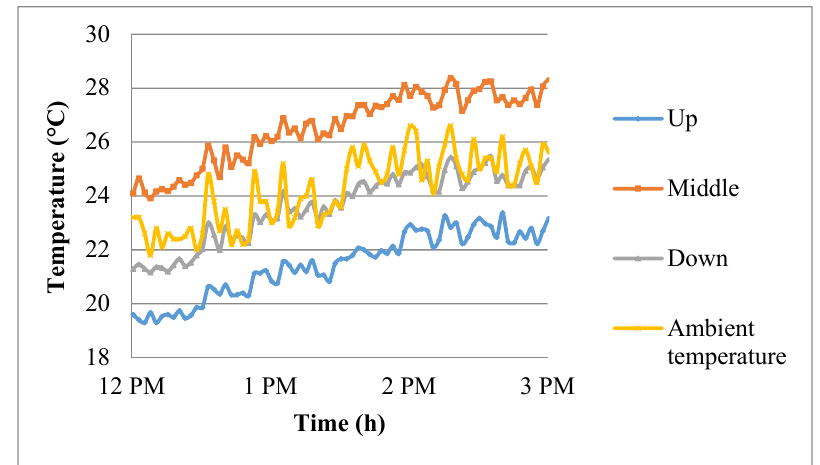
Figure 4. Time-temperature dependencies measured in different distances from the roof of model cowshed without installation of PV module and the ambient temperature.